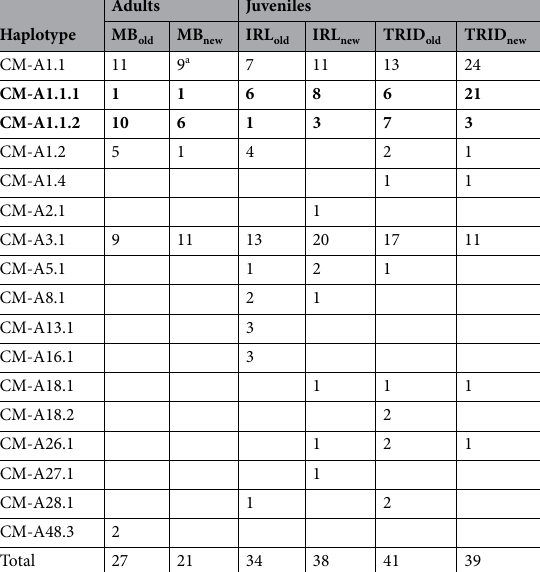
(Supplementary Table S6) to ensure chain convergence by checking the Gelman-Rubin shrink factor (< 1.08). To determine evidence of changes between models, we compared estimates by subtracting the posterior distribu- tions for each estimated parameter between two models (e.g., MSA 3 vs MSA 4 ). The resulting distribution was used in the Test of Practical Equivalence implemented in the R package ‘bayestestR’ 56 against a null hypothesis (CI = 0.89, range = −0.05 to 0.05). In short, the Test of Practical Equivalence evaluates what proportion of the credible interval of the resulting distribution (i.e., 89% CI) that falls inside the range defined as the null (i.e., −0.05 to 0.05) 56 . We chose a credible interval of 89% based on small posterior distributions sample size (< 10,000) 56,57 . Finally, we used linear regressions to test if the mean estimates from models MSA 3 -MSA 6 were correlated to the distance between rookeries and mixed stocks. Results Biometrics. We sampled a total of 200 turtles among the three locations and two time periods (Table 2). The mean SCL of first capture for nesting females in MB old was 100.9 cm (SD 5.1, range 93.4–114.1) and for MB new was 97.8 cm (4.7, 90.5–108.6). For mixed stock samples, the mean size of first capture at IRL old was 46.8 cm (10.8,